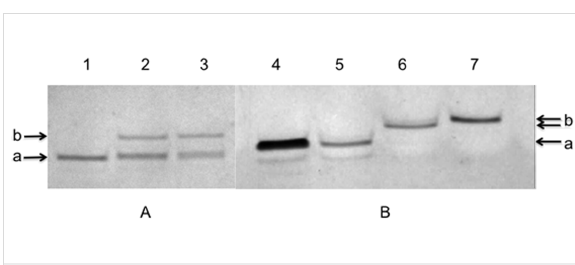
Figure 10: Gel electrophoresis of oligonucleotides modified by alkyne linkers: A – oligonucleotide HIVP (detection by UV-shadowing). Line 1 – control, starting oligonucleotide, lines 2 and 3 – reaction mixtures after its interaction with linker 1 (product 18 ) and linker 2 (product 19 ), respectively. B – oligonucleotide HIVLP modified by linker 1 . Line 4 – control, starting oligonucleotide, lines 5–7 – electrophoresis of indi- vidual products obtained after purification of reaction mixture by HPLC. 5 – initial oligonucleotide, 6 – first peak (product 15 ), 7 – second peak (product 16